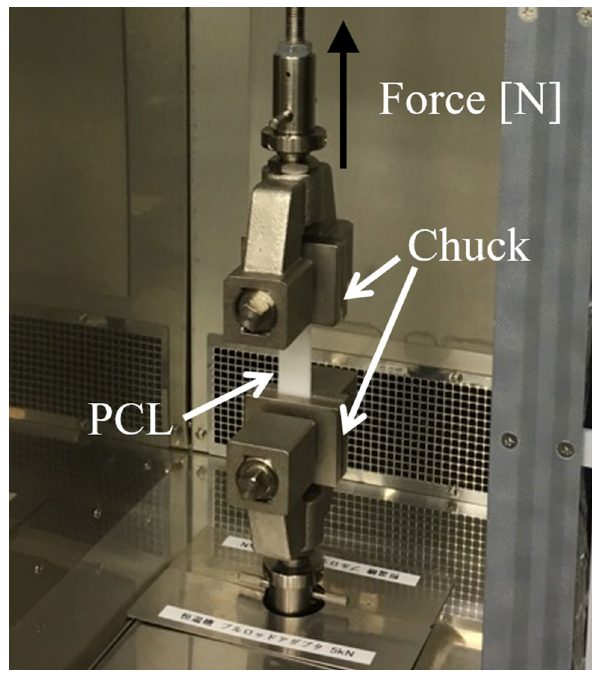
Figure 3. Photographs of the machine for the tensile test. The poly-ε-caprolactone (PCL) is sandwiched between chuck and pulled in the direction of the black arrow at 200 mm/min.